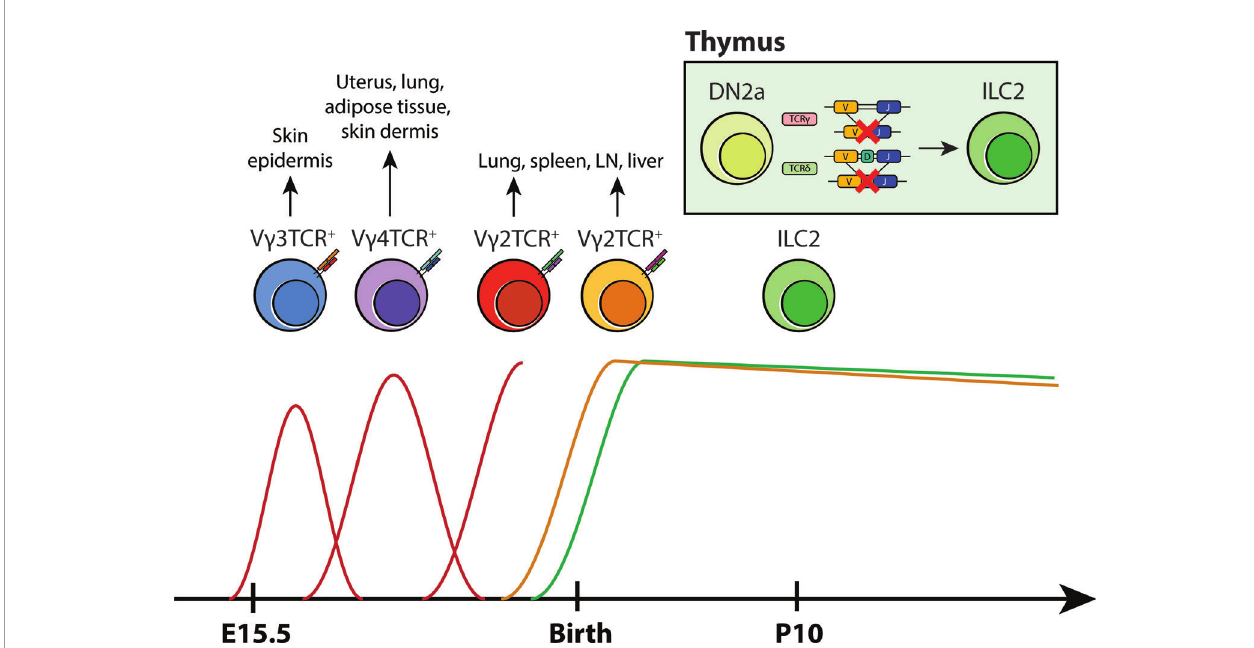
FIGURE 2 | A new model for layered ontogeny of ILC2s along with fetal and postnatal waves of gd T cells. Like most tissue-resident cells, the developmental timepoint in which ILC2s arise and colonize tissues coincides with gd T cells early in life (based on layered ontogeny in B6 mice). Taken together with TCR locus sequence tracing data and pulse-labeling lineage tracing studies, it is highly likely that tissue-resident ILC2s arise perinatally from developing DN2s that have ineffectively rearranged their g / d loci, rather than from progenitors in the BM. These cells then take up residence at their designated tissue sites and self-renew